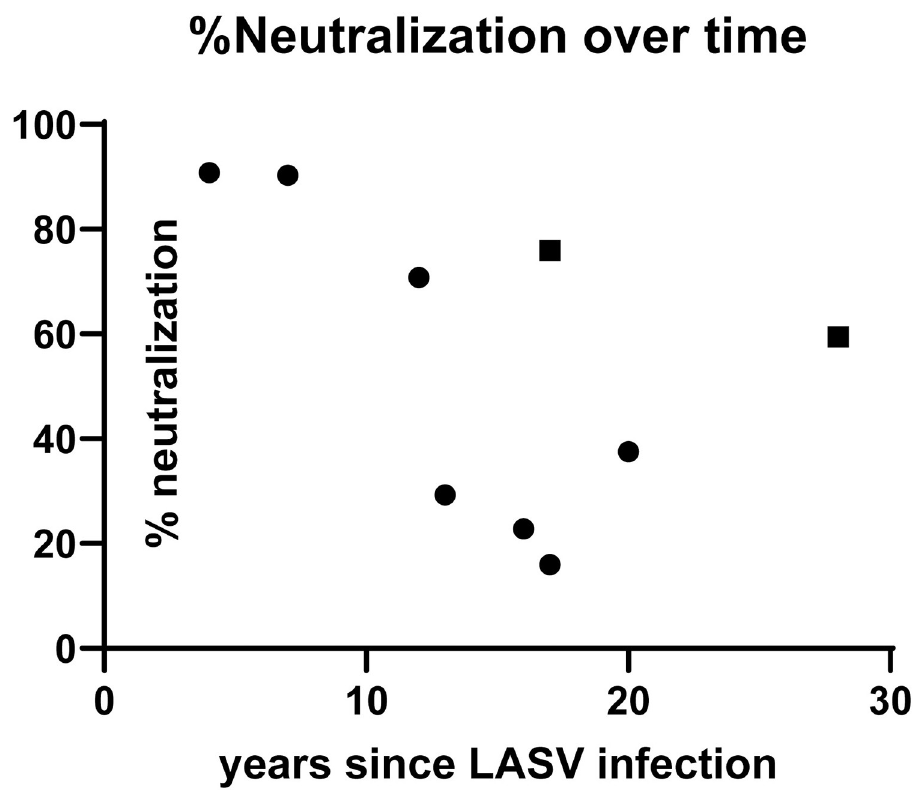
Fig 8. Percent LASV neutralization in LF survivors by years since LF infection. N = 9 Data points depicted as square symbols represent LASV survivors without T cell responses in 10 day expansion assays (N = 2).